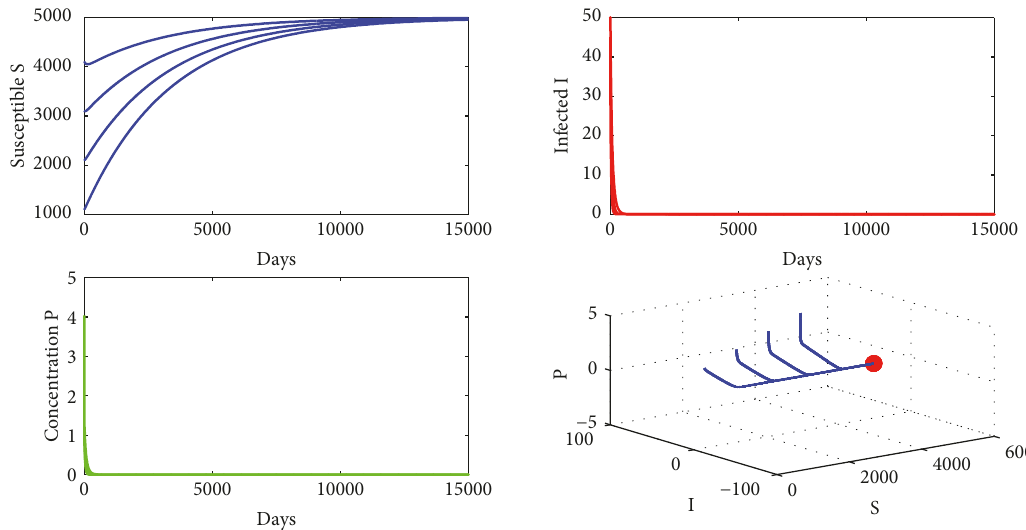
Figure 2: Demonstration of the global stability of the disease-free equilibrium 𝐸 𝑓 for 𝑅 0 = 0.9383 ≤ 1 .